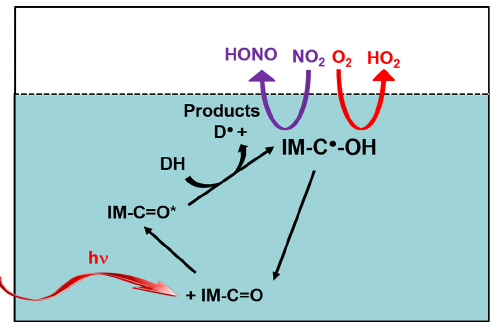
Figure 8. Proposed mechanism, modified and expanded to pho- tosensitization of IC based on Canonica et al. (1995), George et al. (2005) and Aregahegn et al. (2013). The reaction in the white square represents the gas-phase, and the blue square represents the aqueous phase. DH is an H donor (e.g., CA, another IC, H 2 O + CA matrix to be determined from flash